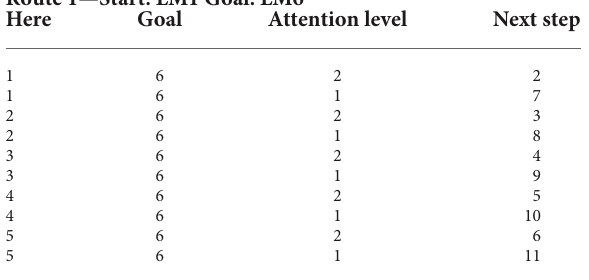
TABLE 2 Rule set of the lookup table based fuzzy system for Route 2 with the starting point at LM4 and ending at LM1 from the assumed cognitive map in Figure 3.